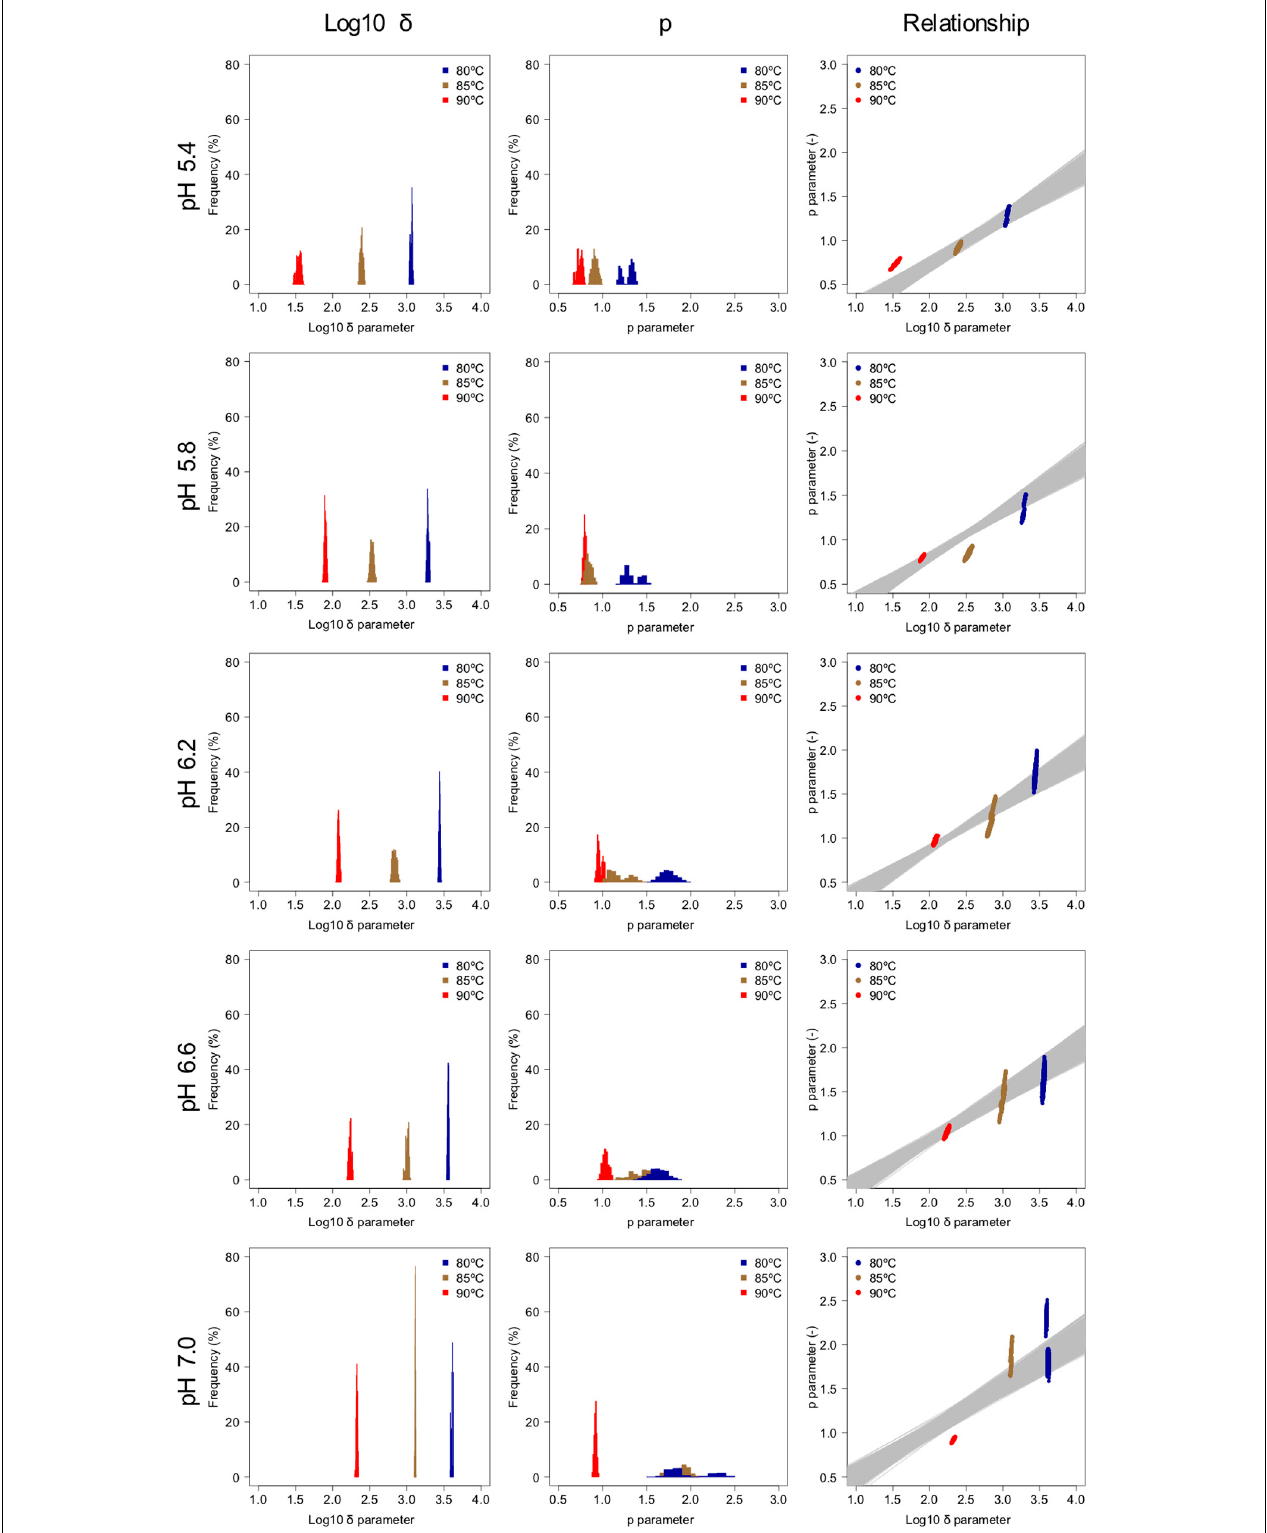
FIGURE 5 | Weibullian parameter distributions under each condition derived from 1,000 bootstrap replicates, and the relationship between the two bootstrapped Weibullian parameters. The gray lines indicate the relationship between the two estimated parameters from bootstrapped secondary model sets.